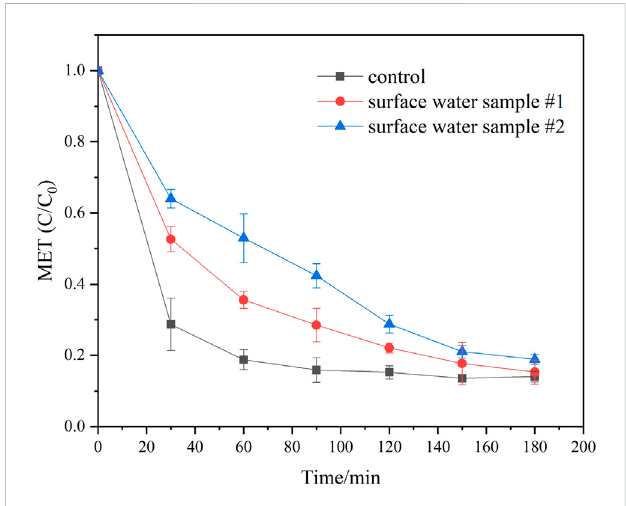
FIGURE 6 Bio-toxicity change of the testing solution during MET